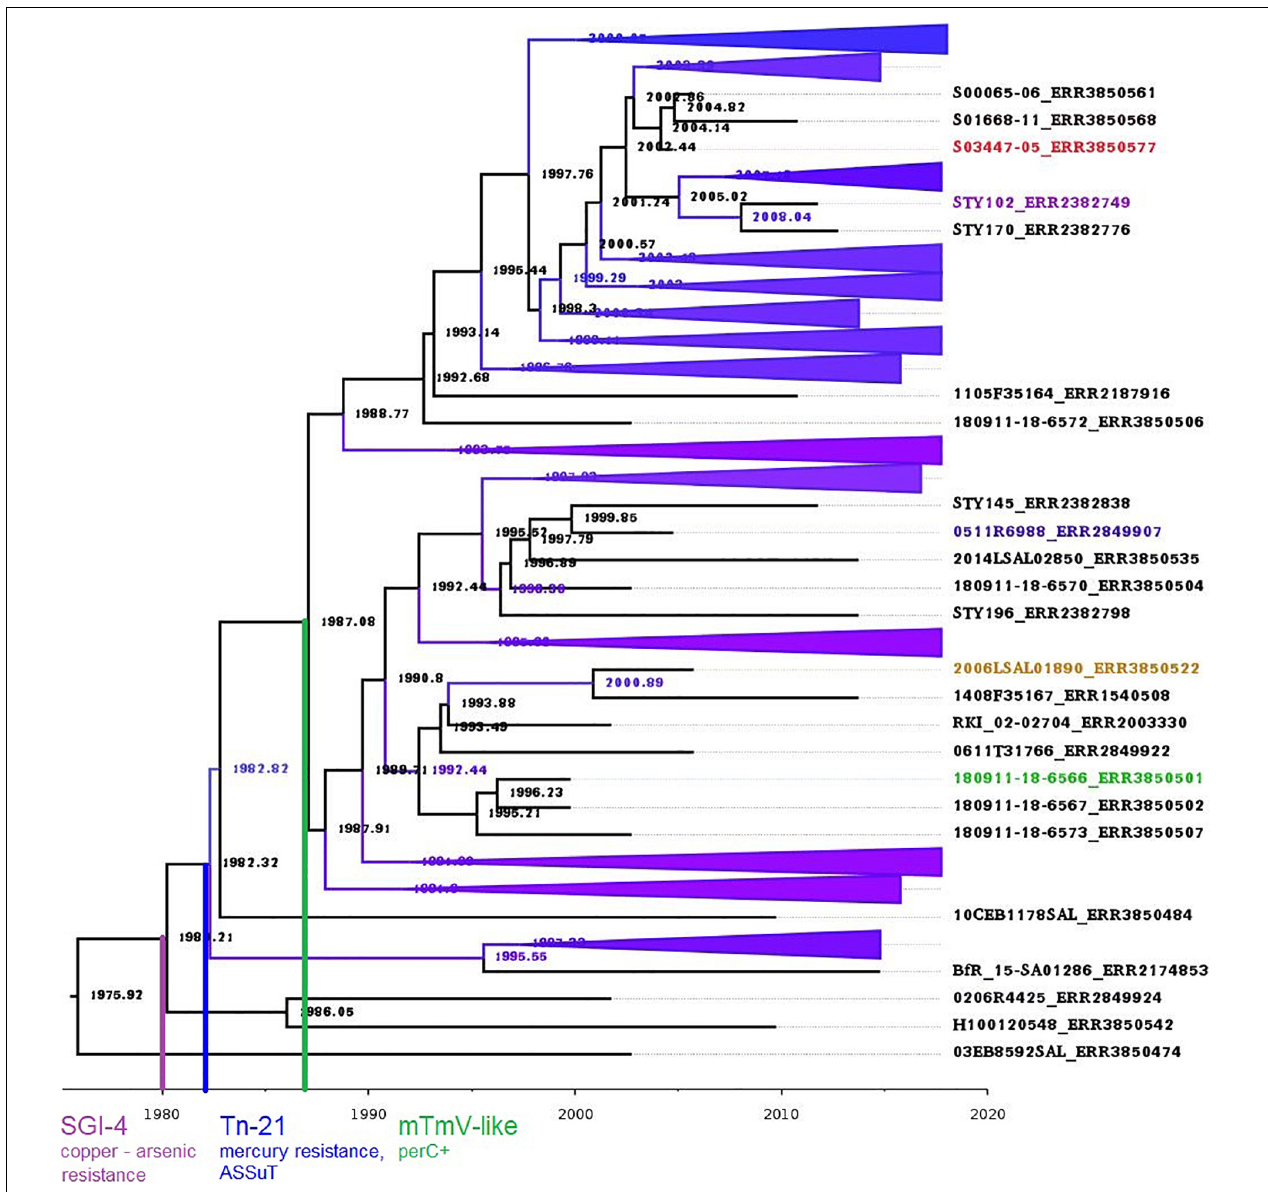
FIGURE 3 | Bayesian analysis of the 205 genomes belonging to the clade A. Time-scale with the steps of evolution of S . 1,4,[5],12:i:- European clone ST34 is reported at the bottom. In green (DE), yellow (FR), blue (DK), purple (IT), and red (UK) the first S . 1,4,[5],12:i:- strains per country of our